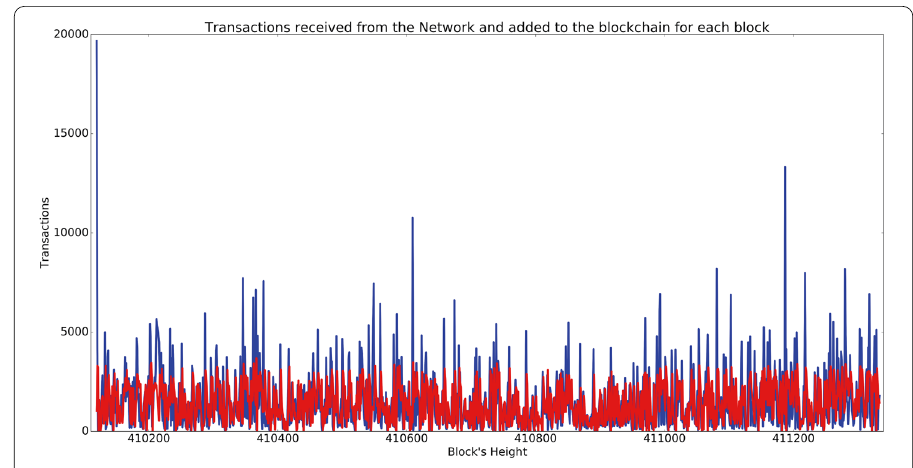
Figure 1 Transactions per block. This figure compares the number of Transactions observed during block mining (in blue) and the number of transactions included in the Blockchain during the same block mining time (in